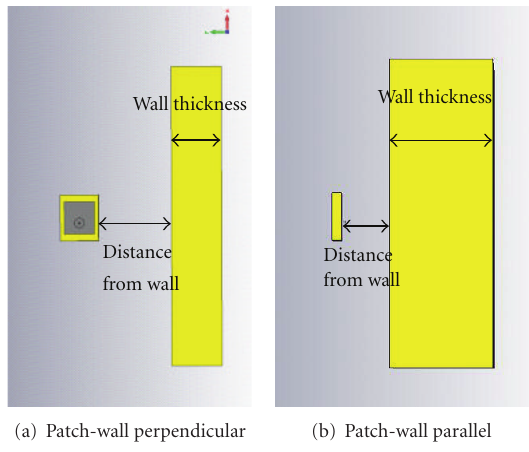
Figure 1: Patch antenna locations and parameters.